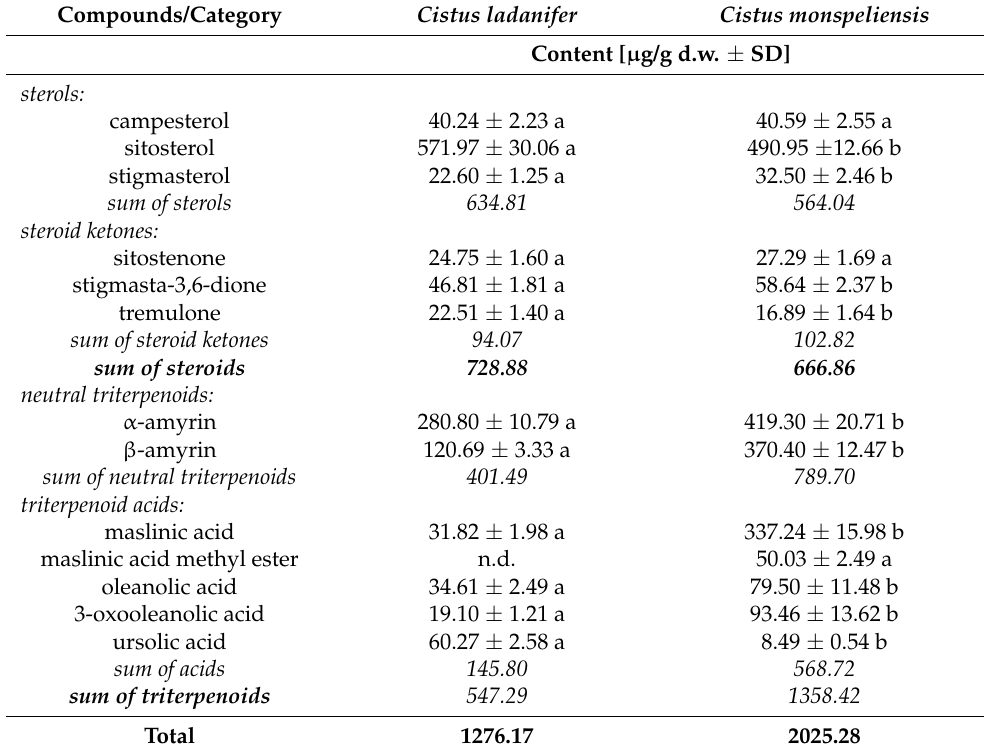
Table 1. Content of steroids and triterpenoids in Cistus ladanifer and Cistus monspeliensis leaves. Compounds/Category Cistus ladanifer Cistus monspeliensis Content [ µ g/g d.w. ± SD] campesterol 40.24 ± 2.23 a 40.59 ± 2.55